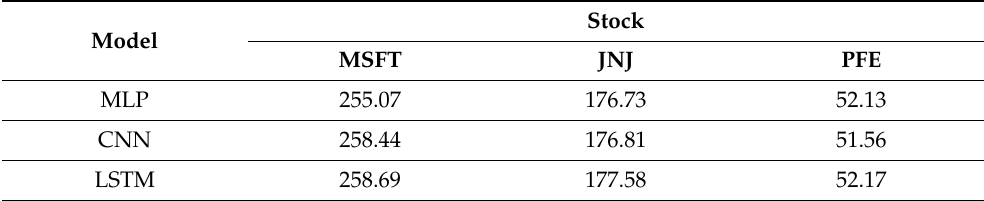
Table 8. One-step-ahead prediction of MSFT, JNJ and PFE stocks obtained from the two-delay combination model on 1 July 2022 at 9.30